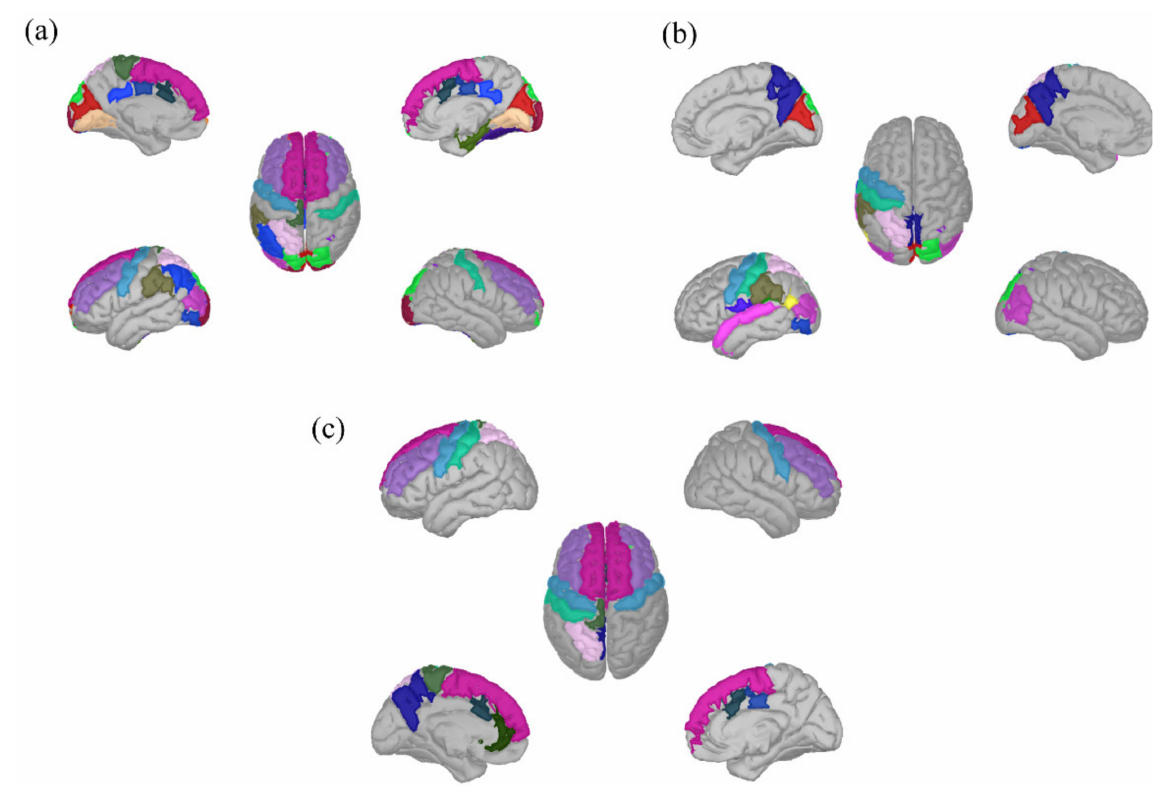
Figure 4. Networks of interest. The present figure represents the nodes included in each of the three networks of interest, namely expectancy implementation network ( a ), expectancy violation network ( b ) and response implementation network ( c